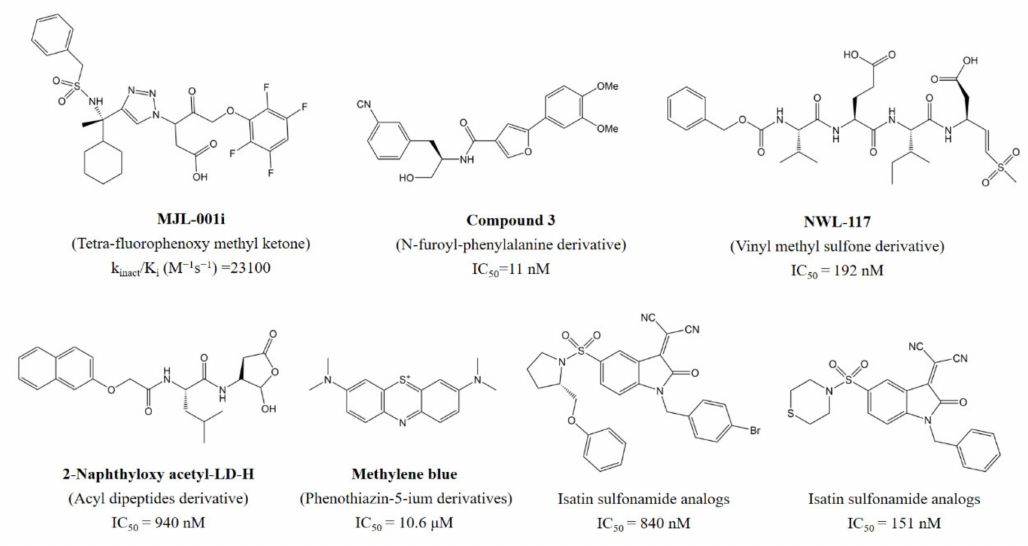
Figure 1. Representative structures of caspase-6